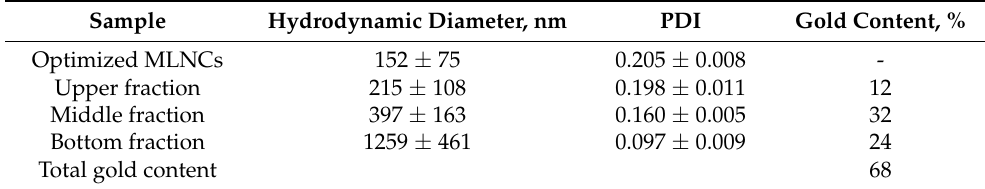
Table 3. Physicochemical characteristics of optimized MLNCs after fractionation at 2000× g for 30 min.